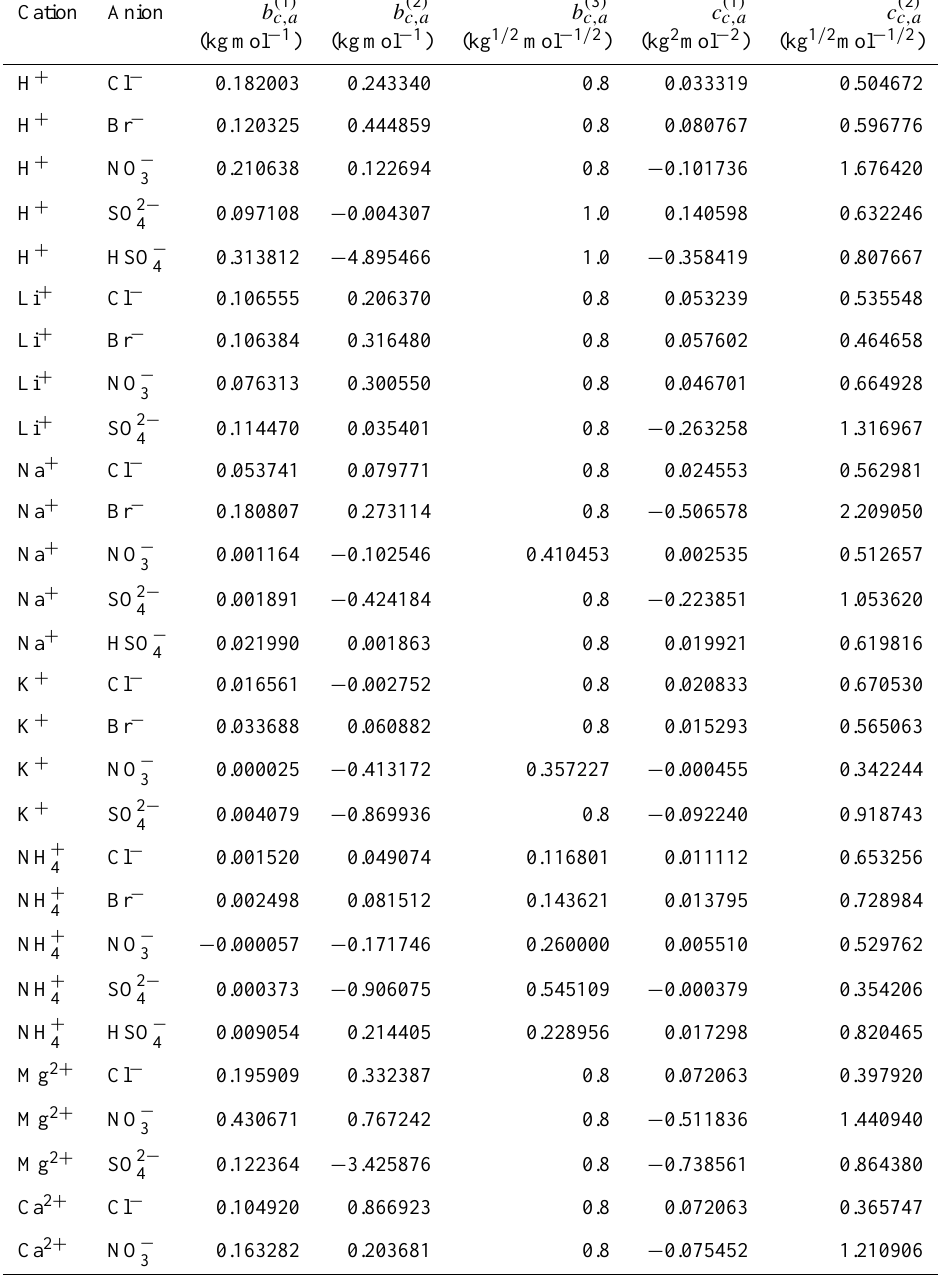
Table A3. AIOMFAC binary cation ↔ anion MR interaction